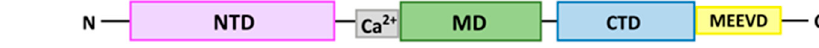
Figure 2. Domain structure of the HSP90 protein. The N-terminal domain (NTD) mediates ATP binding, the middle domain (MD) is involved in the hydrolysis of ATP and the binding of HSP90 to substrates (client protein) and the C-terminal domain (corboxy-terminal domain, CTD) is responsible for HSP90 dimerization, containing the motif Met-Glu-Glu-Val-Asp